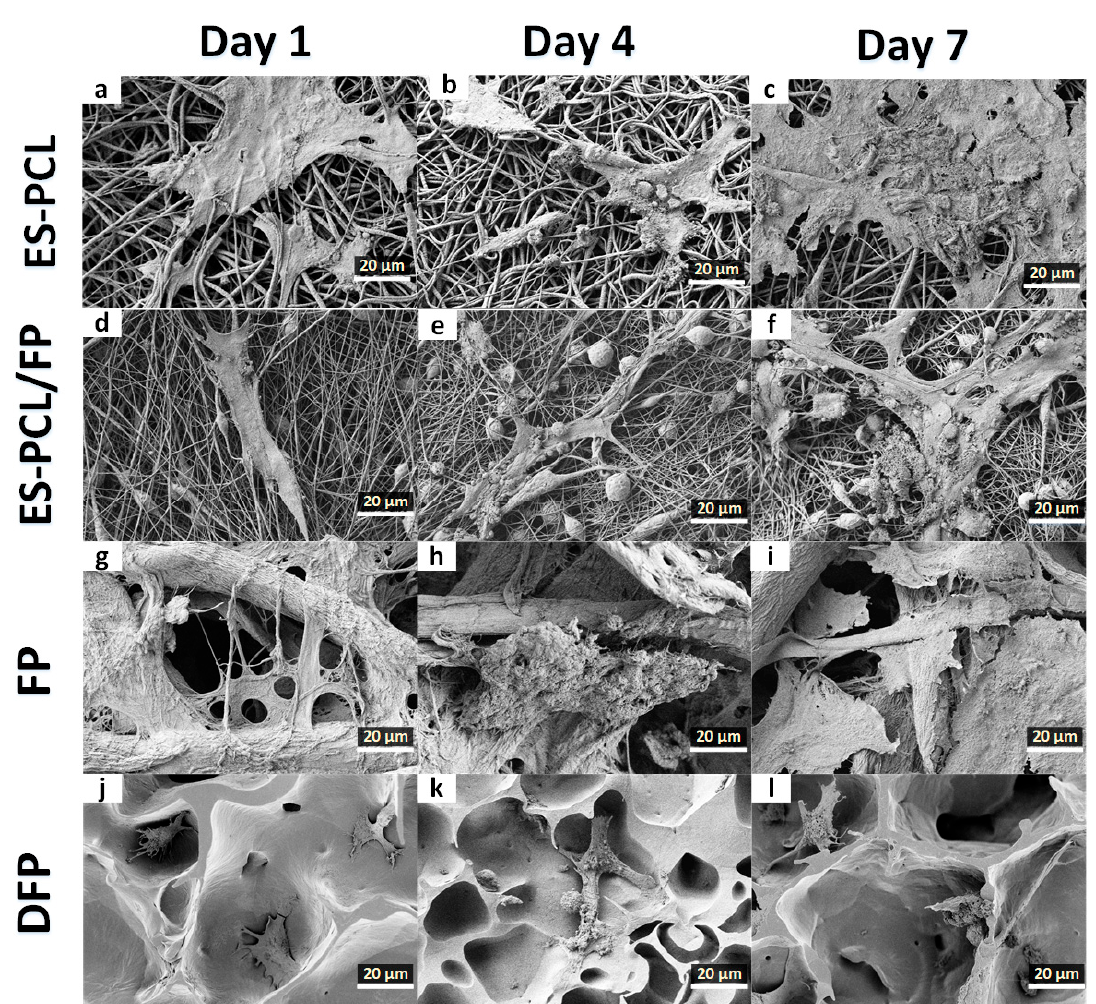
Figure 3. Cell morphological analysis. FESEM images showing the morphology of human fetal osteoblast (hFOB) plotted separately for each individual scaffold of ES-PCL ( a–c ), ES-PCL/FP ( d–f ), FP ( g–i ), and DFP ( j–l ) on different days. The magnification and resolution of all images are the same.